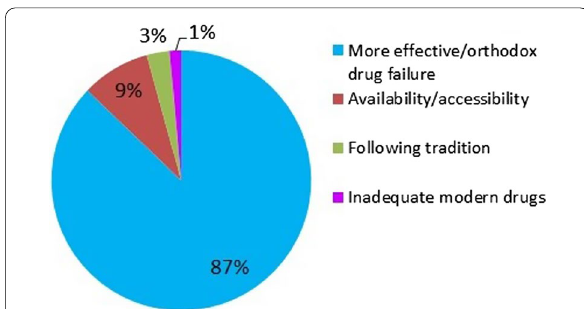
Fig. 5 Reasons for choice of herbal remedies